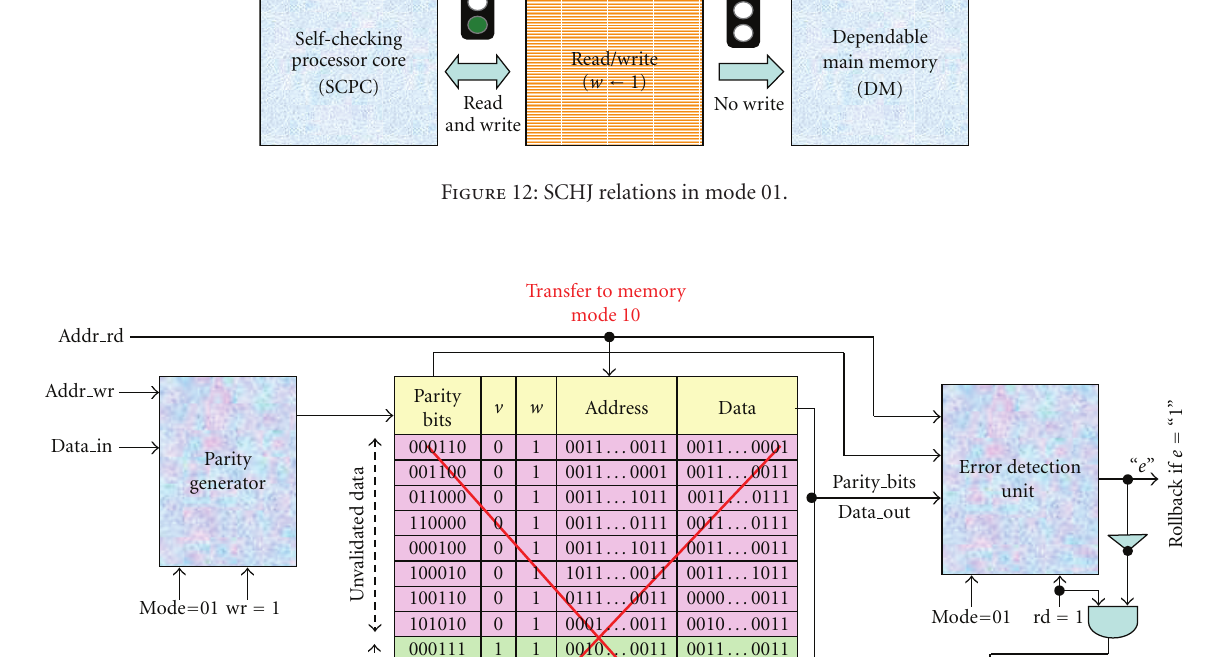
to reset the processor and clear the SCHJ. The faults considered are SEUs (Single Event Upsets: only one bit changes in a single register) and MBUs (multiple bits change at once in one register), injected at a randomly chosen moment. The corresponding error patterns are shown in Figure 20: (a) SEU (single bit error); (b) 1 up to 2-bit MBU; (c) 1 up to 3-bit MBU; (d) 1 up to 8-bit MBU. These fault patterns are commonly used ones in RTL models [35,